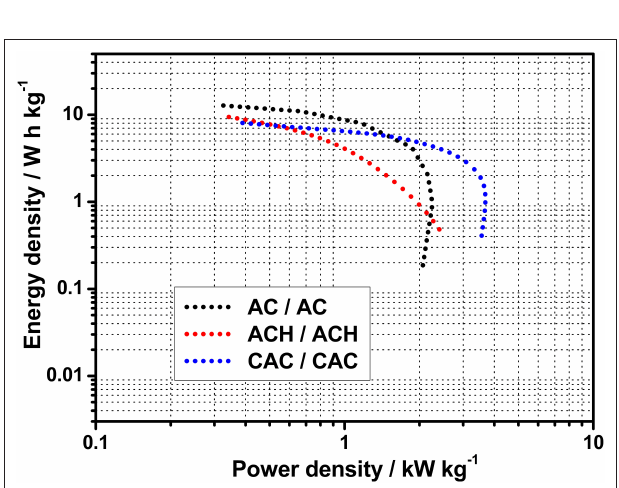
FIGURE 4 | Ragone plot for asymmetric supercapacitors of AC ( 1 V = 1.8V), ACH ( 1 V = 1.7V), and CAC ( 1 V = 2.0V) before durability